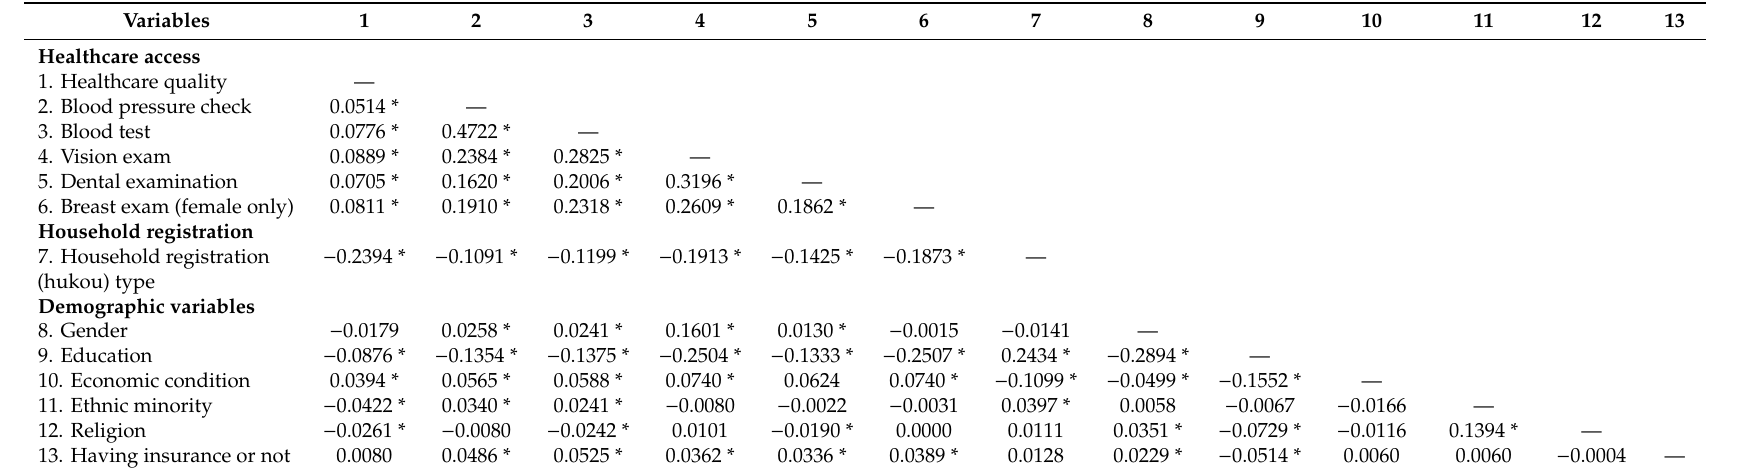
Table 2. Pairwise correlation matrix of variables in main